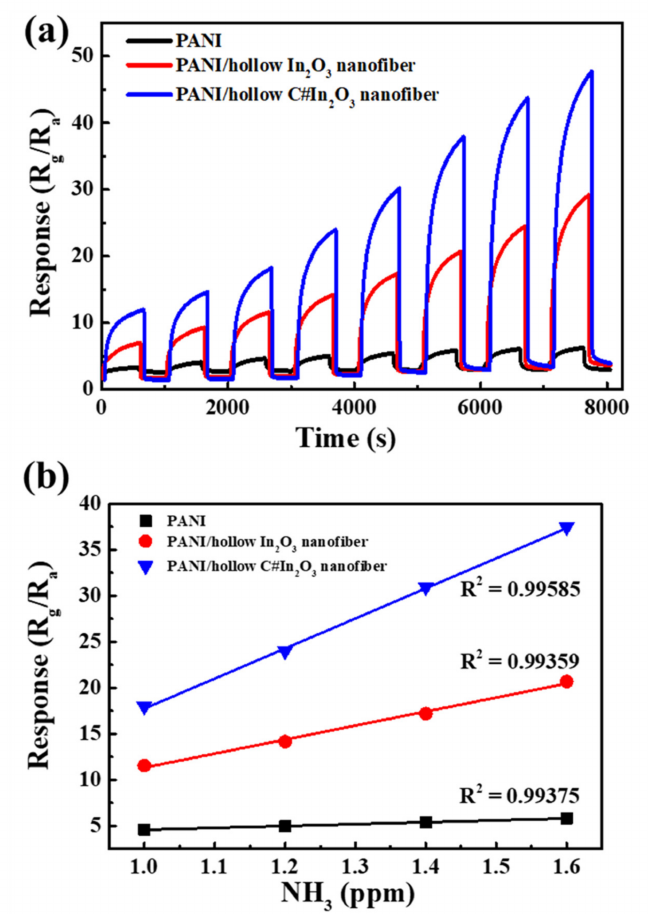
Figure 8. The ( a ) dynamic response–recovery curves shown in the concentration between 0.6 ppm and 2.0 ppm, and ( b ) the fitting curves of response versus concentration for PANI, PANI/hollow